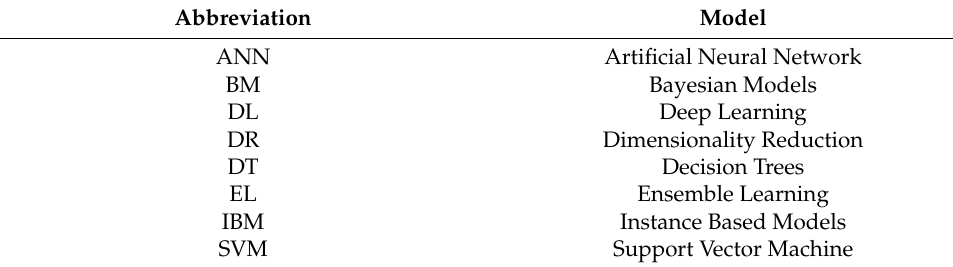
Table A10. Abbreviations for machine learning models.